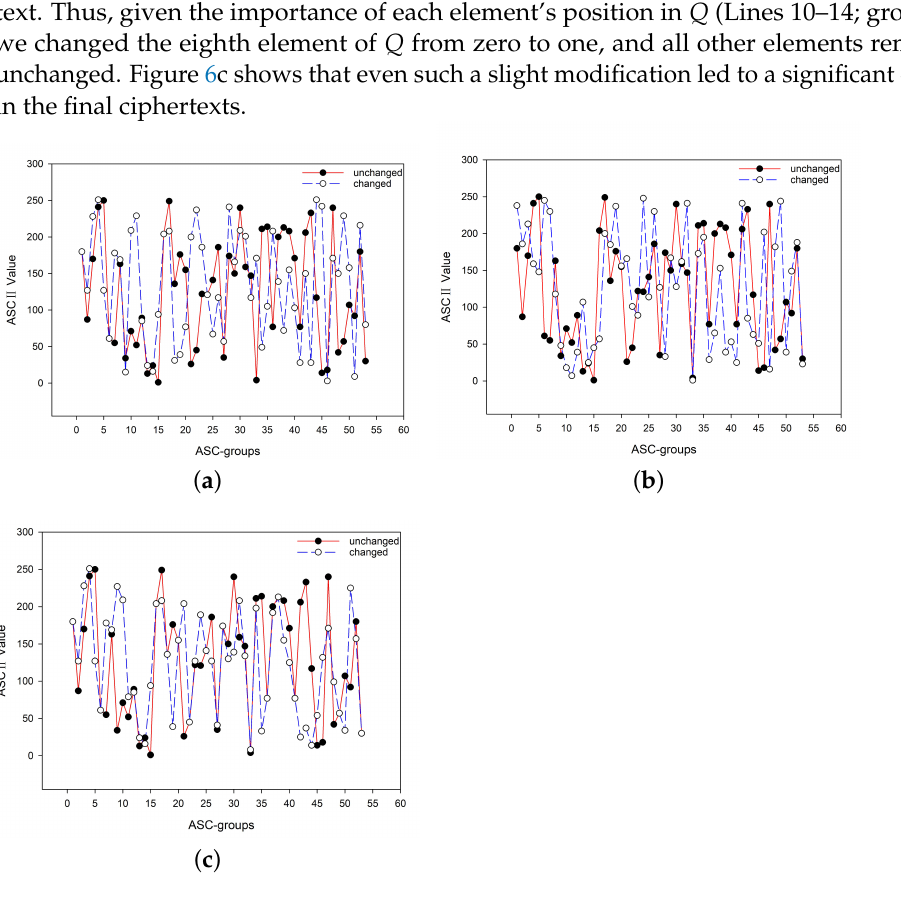
Figure 6. Key sensitivity tests, where the horizontal axis displays the specific ASC-groups, and the vertical axis presents the corresponding ASCII value of each ASC-group. The corresponding ASCII values exhibit great differences when factors related to the key are changed: ( a ) change one base; ( b ) change experimental conditions; ( c ) change one element in the process of extending the